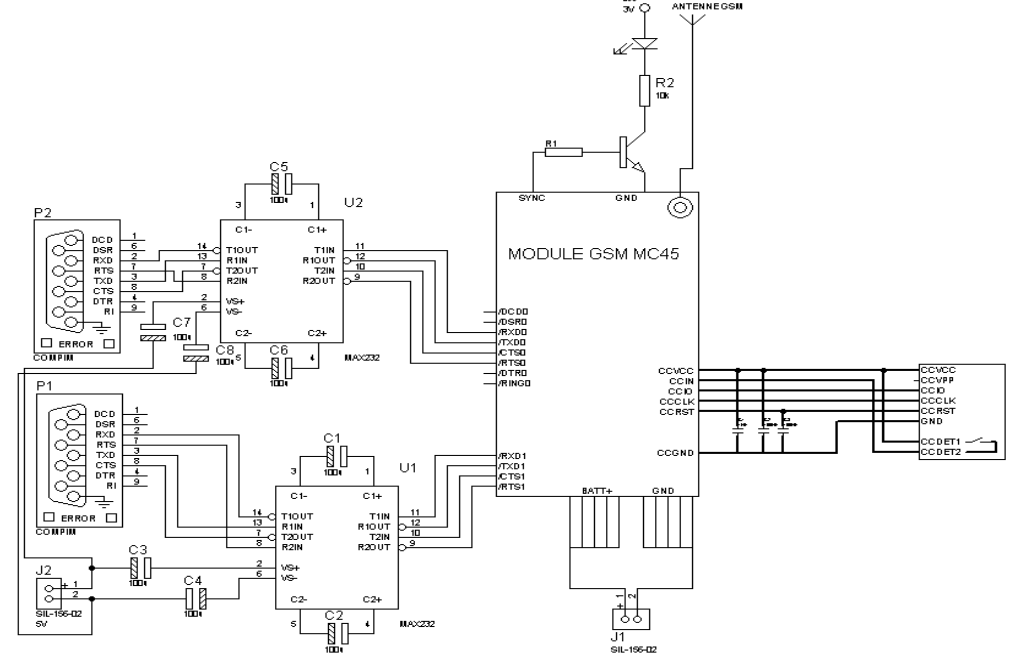
Figure 19. GSM/GPRS MC45 module attached to a RS 232 serial